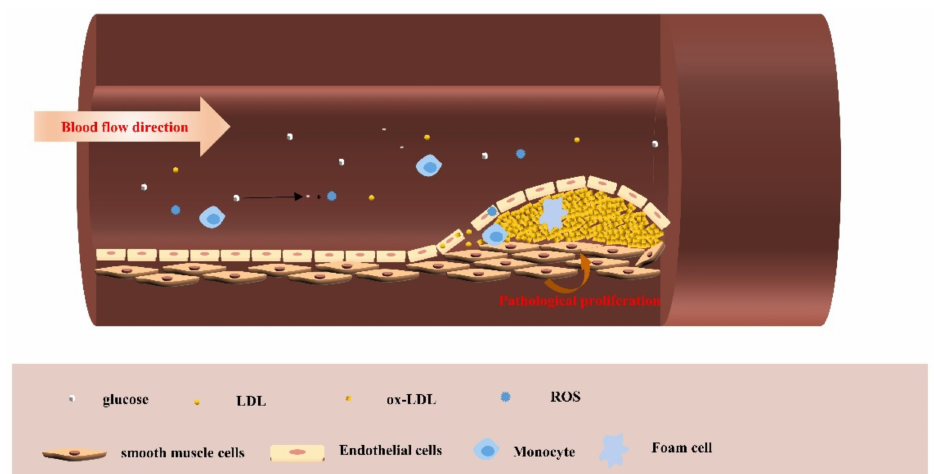
Figure 2. The effect of ROS on the cardiovascular system caused by hyperglycemia. Oxidative stress caused by glucose auto-oxidation leads to endothelial dysfunction and pathological proliferation of smooth muscle cells, which ultimately leads to the formation of vascular